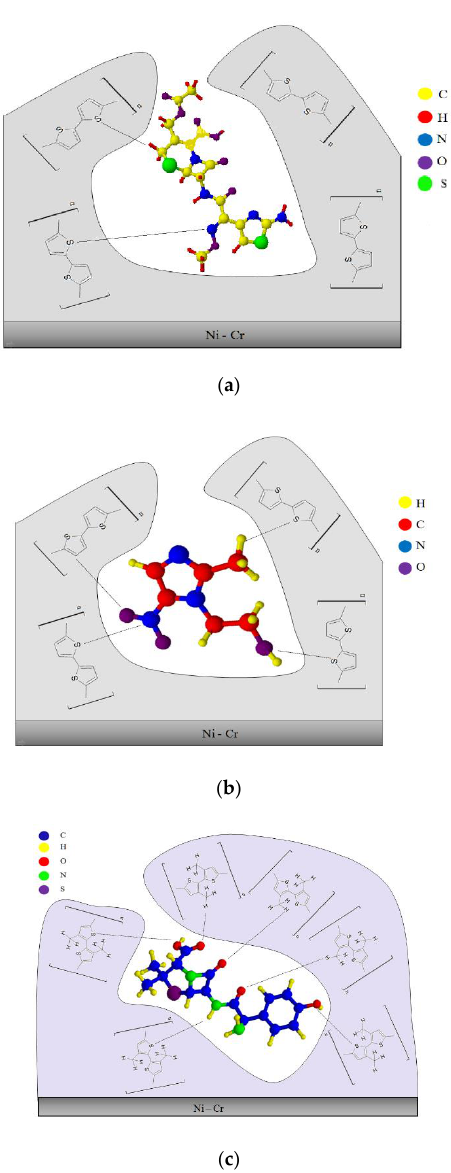
Figure 9. Proposed mechanism of the sorption of cefotaxime ( a ), metronidazole ( b ) and amoxicillin ( c ) molecules on the surface of PTh-SPME fiber and PMeTh-SPME fiber.